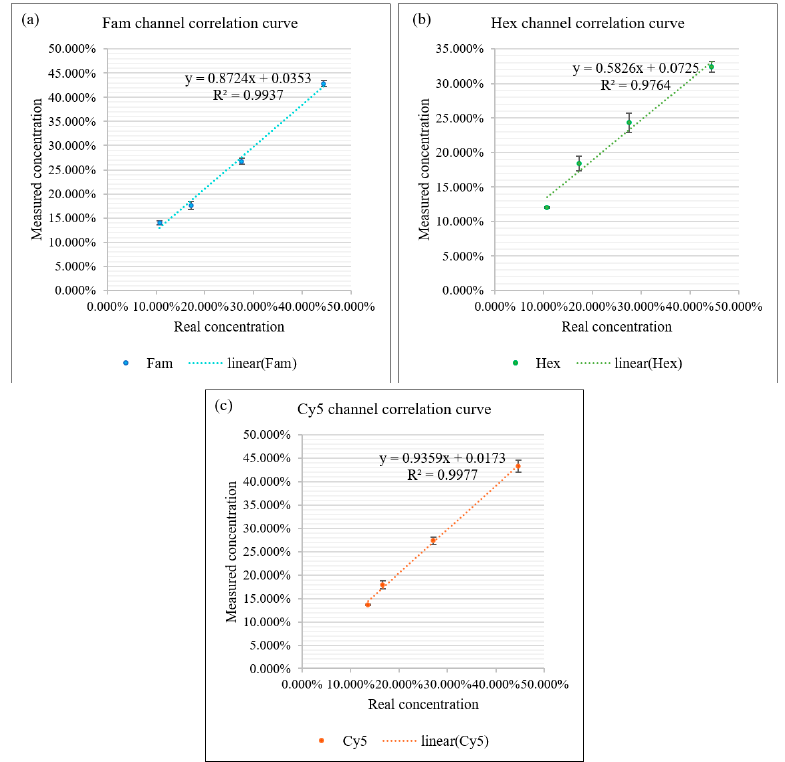
Figure 6. Correlation curves and standard errors of measured and true values of concentration gradients for the three fluorescence channels. ( a ) Correlation curves and standard errors of measured and true values for four concentrations in Fam channel. ( b ) Correlation curves and standard errors of measured and true values for four concentrations in the Hex channel. ( c ) Correlation curves and standard errors of measured and true values for four concentrations in Cy5 channel.